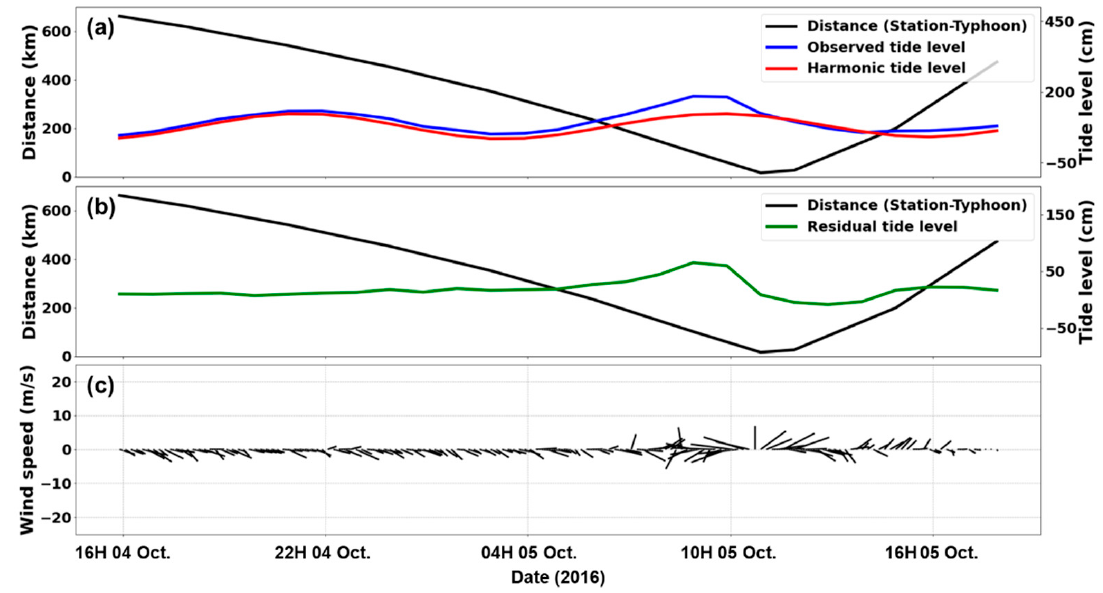
Figure 6. Time-series of observational data from Busan tidal station during Typhoon Chaba. ( a ) Astronomical tide, ( b ) residual tide level, and ( c ) wind components, where direction and length indicate wind direction and speed, respectively.